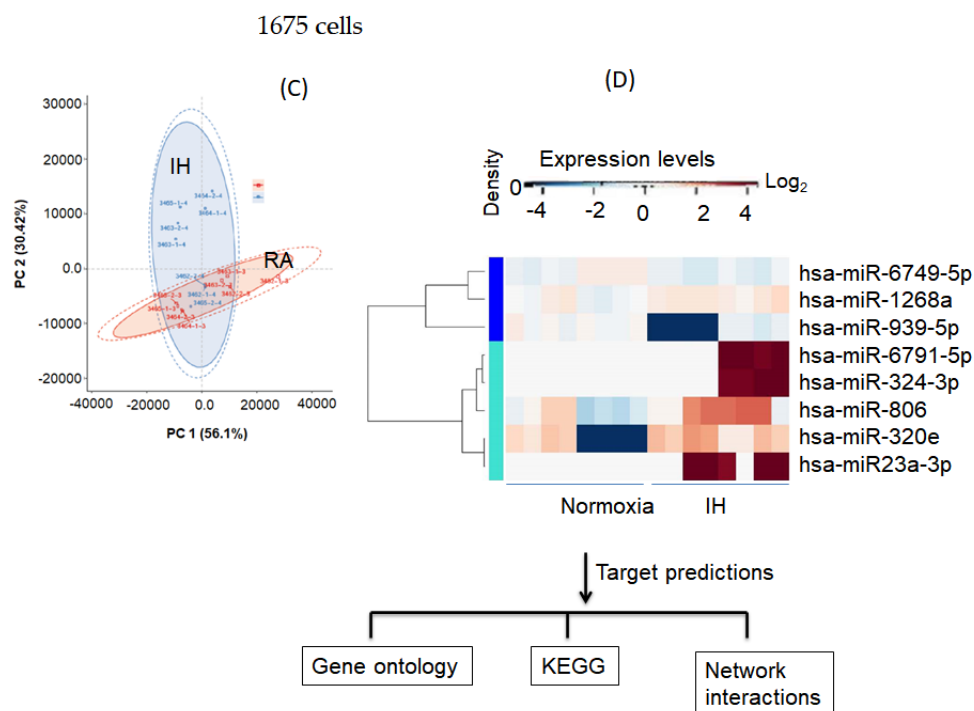
Figure 5. Differentially expressed exosomal miRNAs derived from the supernatants of melanoma cells (CRL-1424 and CRL-1675) after exposures to normoxia (RA) and IH conditions. Panel ( A ) shows a principal component analysis (PCA) plot of exosomal miRNAs for CRL-1424 cells. PCA clustering of miRNA expression by subject group is denoted by different colors and reveals complete and accurate separation of miRNA expression across the subjects from the two groups. Panel ( B ) shows a heatmap illustrating miRNA expression patterns (dark red, increased miRNA expression, light blue, reduced miRNA expression in exosomes. Panel ( C ) shows the PCA of exosomal-miRNA. Panel ( D ) shows a heatmap illustrating miRNA expression patterns for CRL-1675 cells. The dendrograms show hierarchical clustering representing the similarities and dissimilarities in expression profiles among individuals and miRNAs. In silico target gene predictions were used for GO, KEGG pathways, and gene network interactions.